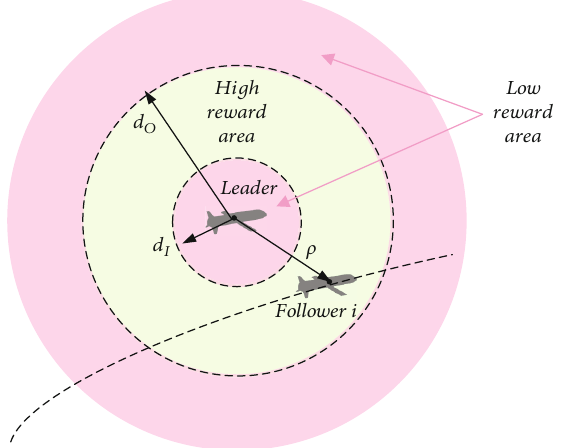
Figure 3: UAV formation collision avoidance